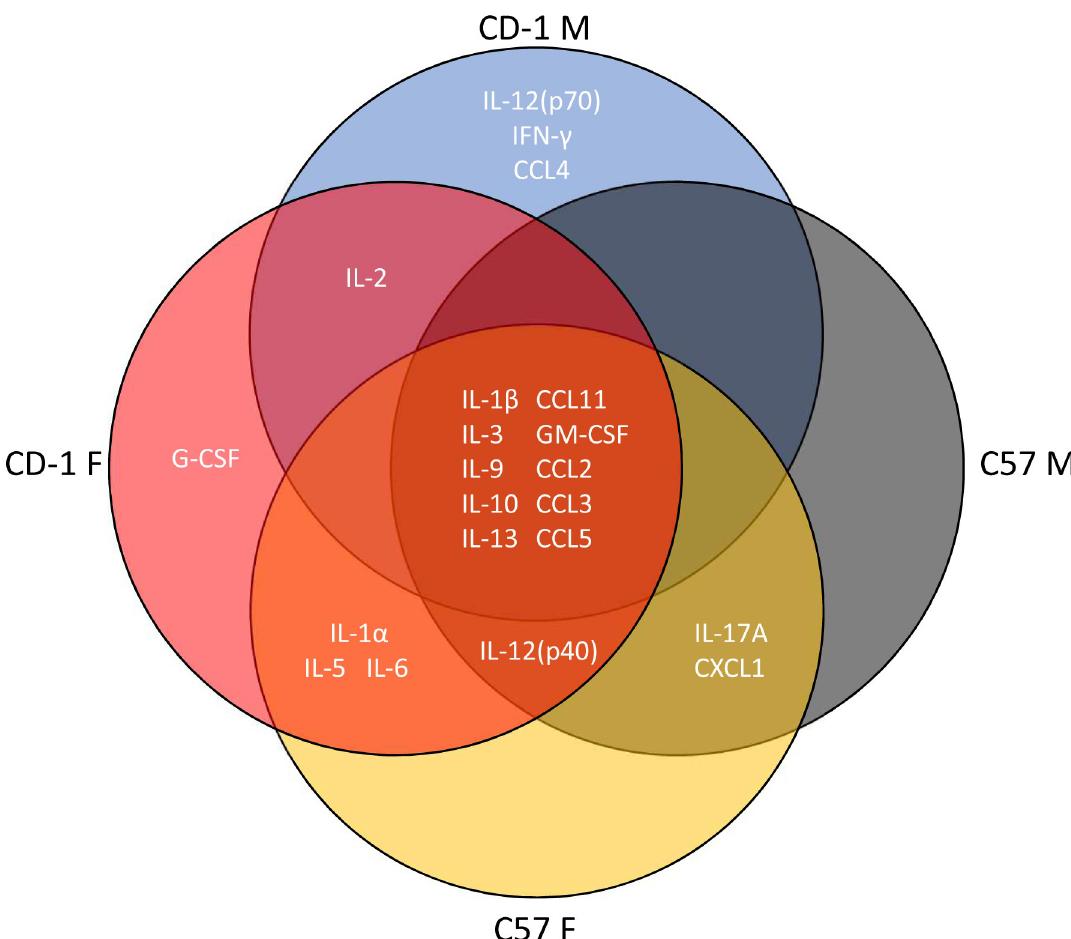
Fig 4. Venn diagram of significant cytokine elevations in serum following LPS treatment according to sex and strain.